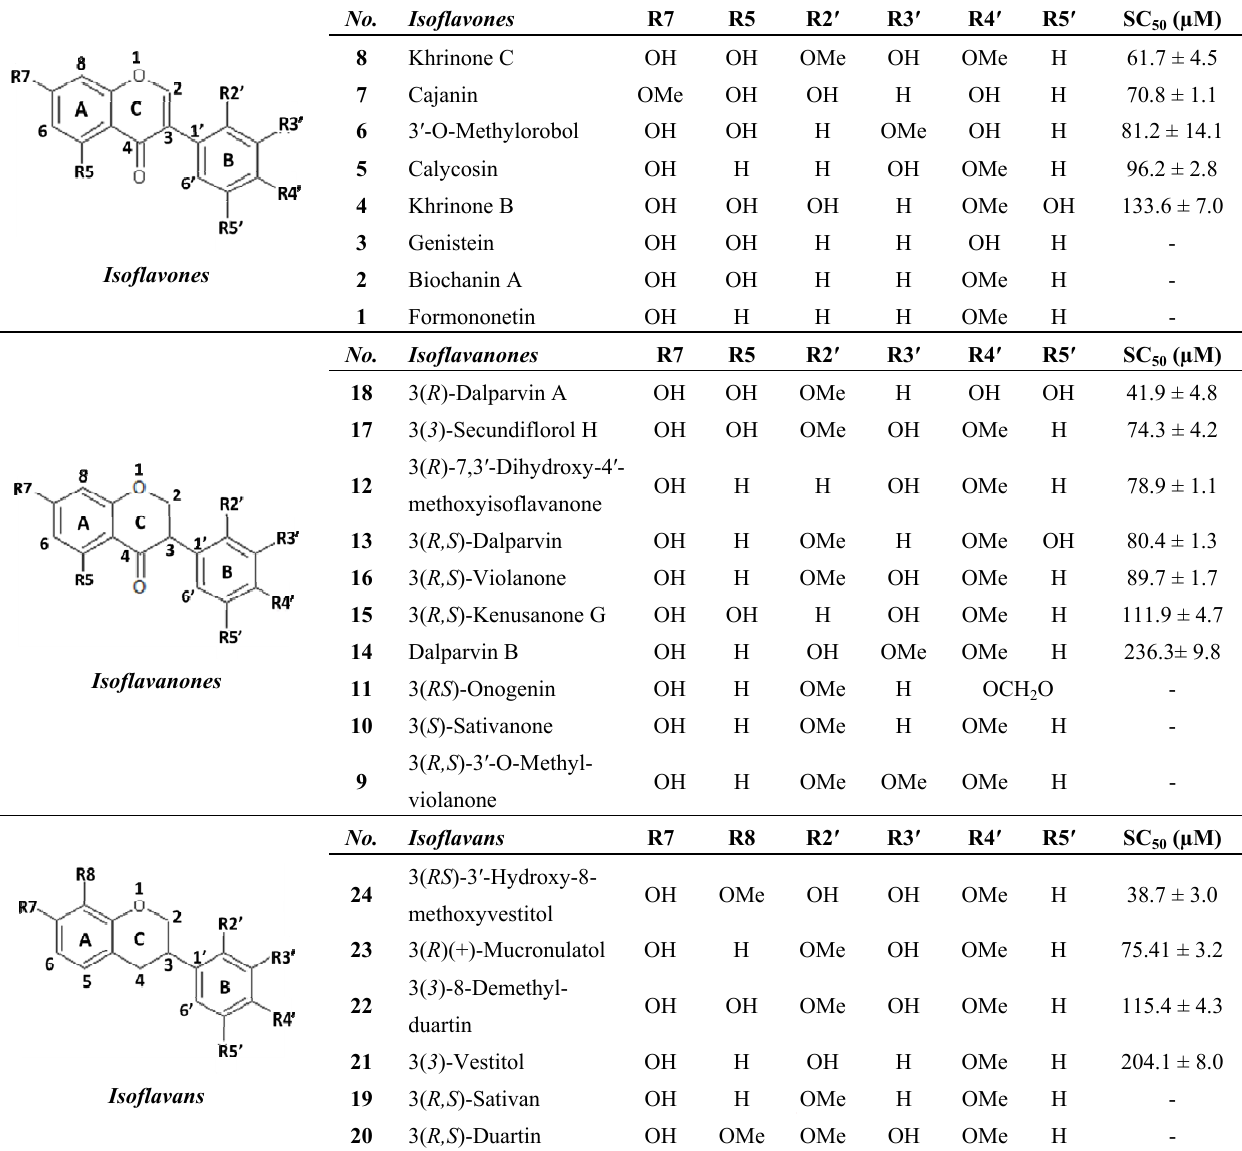
Table 4. SAR of D. parviflora isoflavonoids based on the DPPH radical scavenging activity. No.